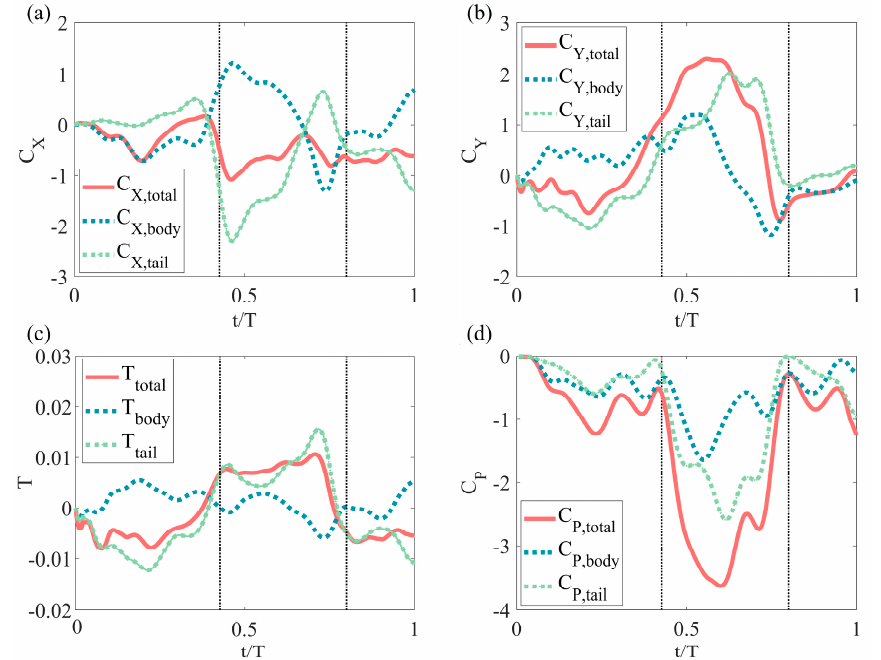
Figure 6. Hydrodynamic parameters of the fast start. Force coefficient in X ( a ) and Y ( b ) directions and torque ( c ) and hydrodynamic power output ( d ) of the entire body, the body trunk, and the tail.